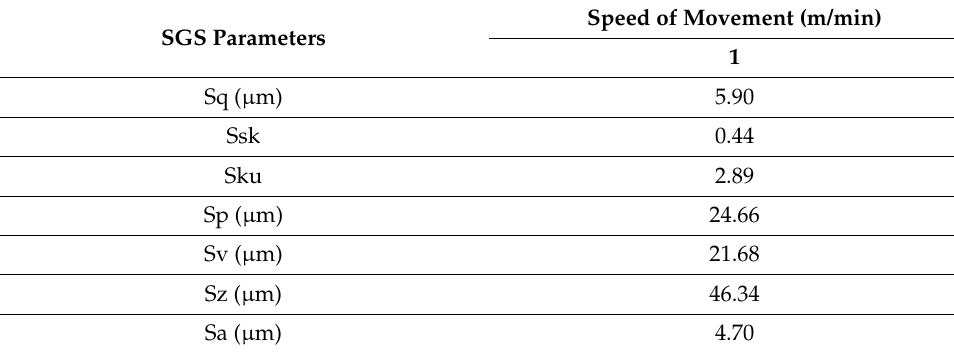
Table 10. Parameters of the SGS after laser alloying (sample 2).